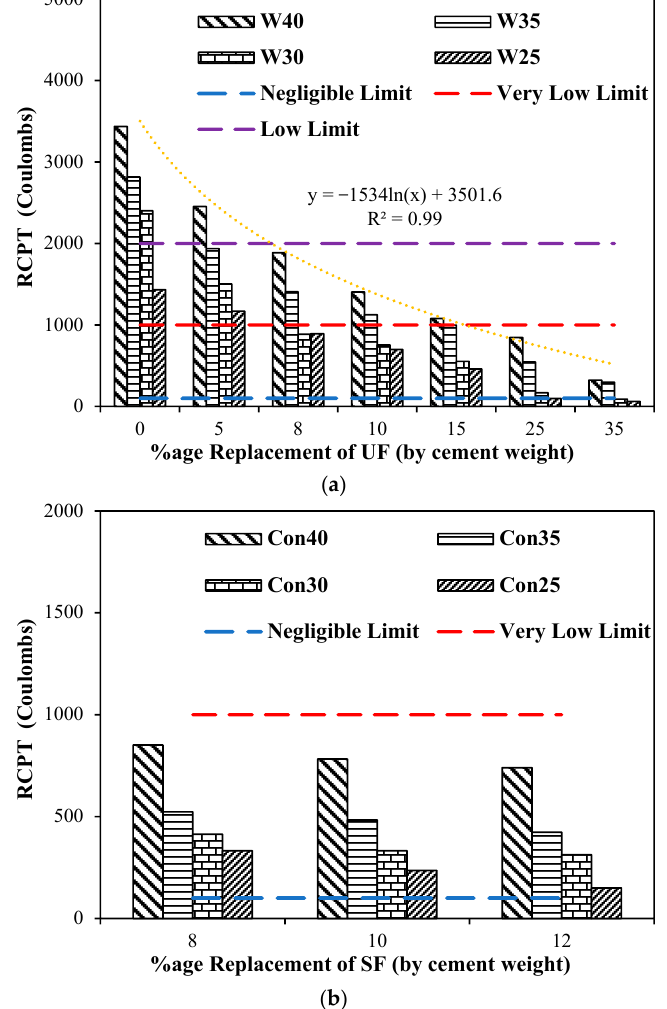
Figure 8. Rapid chloride ion penetrability (coulombs) for different dosages of UF and SF with different w/c ratios: ( a ) RCPT (coulombs) for different dosages ultrafines with different w/c ratios; ( b ) RCPT (coulombs) for different dosages SF with different w/c ratios.